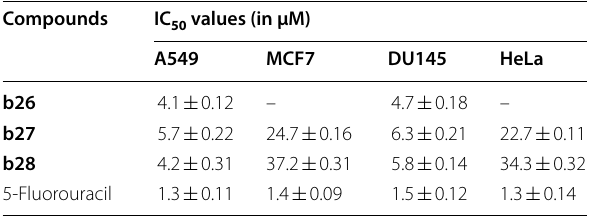
Table 25 In vitro cytotoxicity of most active compounds Compounds IC 50 values (in µM)